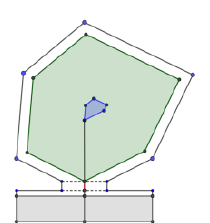
Figure 3. A partial deflation of the corridor.